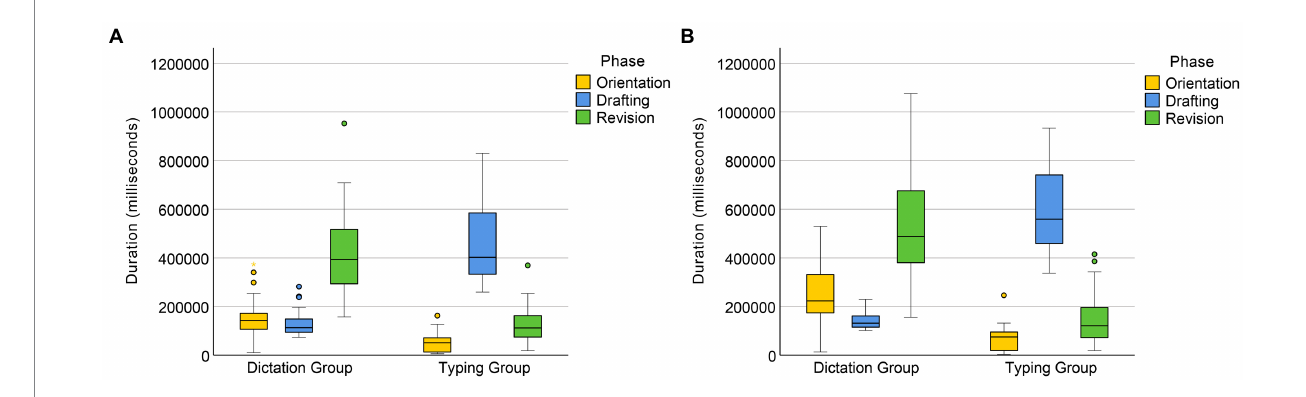
FIGURE 2 Time allocation in the translation of Texts 1 (A) and 2 (B) .